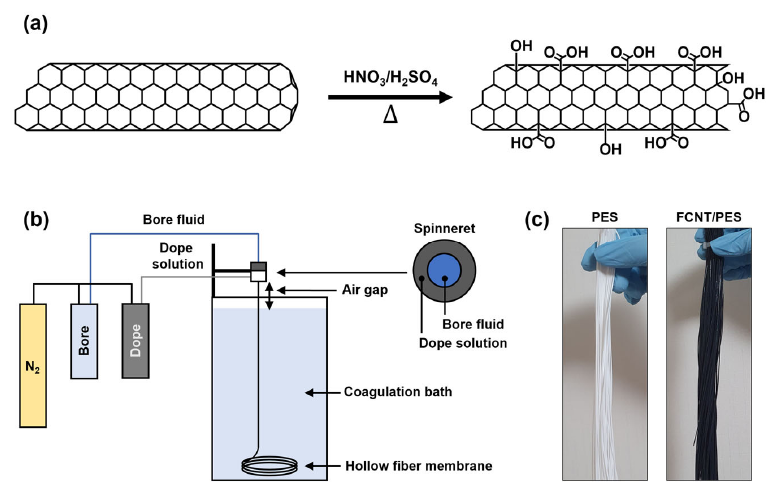
Figure 1. Schematic illustrations of FCNT/PES nanocomposite HF membrane preparation. ( a ) Acid